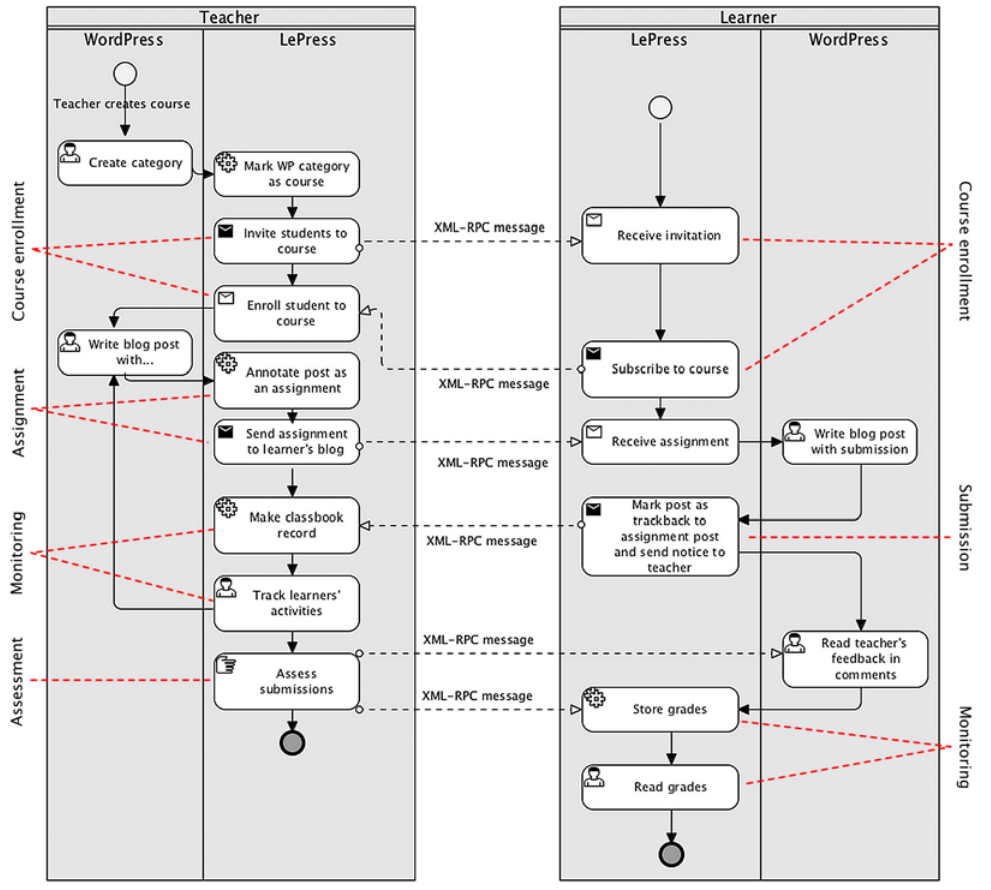
Figure 3 . Learning activities of